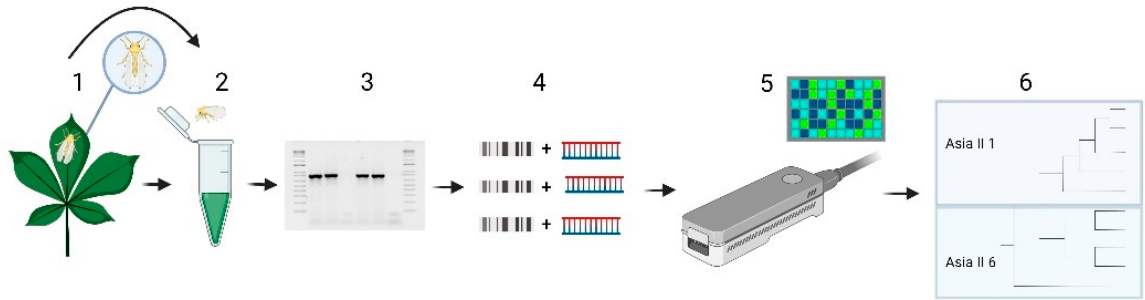
Figure 1. Workflow employed in this work. 1—collected sample, 2—direct PCR using the whole whitefly, 3—confirm the PCR by electrophoresis, 4—library preparation, 5—sequencing using Nanopore Tech, 6—data analysis. Created with Biorender.com (Toronto, ON, Canada).